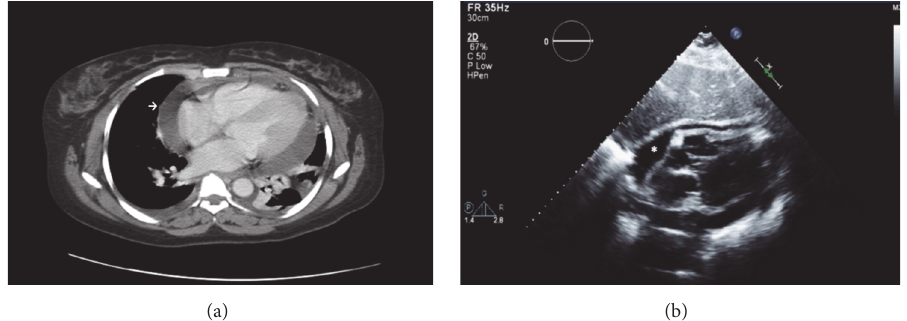
Figure 1: (a) CT showed cardiomegaly with large pericardial effusion (arrow). Bilateral pleural effusions. Left lower lobe is nearly completely collapsed. (b) Parasternal long-axis echocardiogram showed pericardial effusion of moderate size with diastolic compression of the right atrium (asterisk).